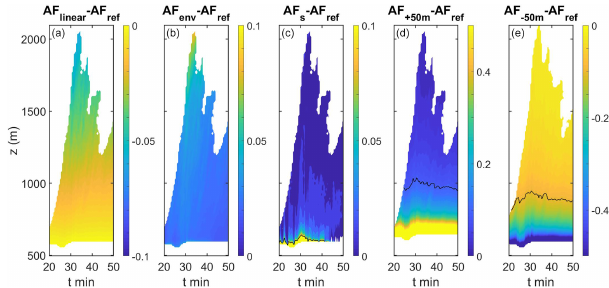
Figure 6. Mean differences in AFs vs. time and altitude for a pol- luted cloud. The horizontal average of the difference of each as- sumption from AF ref for regions with AF ref > 0 . 5 is presented. (a) The difference between the linear method AF linear and AF ref . (b) Same as (a) for AF env . (c) Same as (a) for AF s . (d) The error in AF produced by an error of + 50m in cloud-base height. (e) Same as (d) for − 50m. The black contour marks the 0.1 or − 0 . 1 devia- tion. Note the different scales for the different panels.